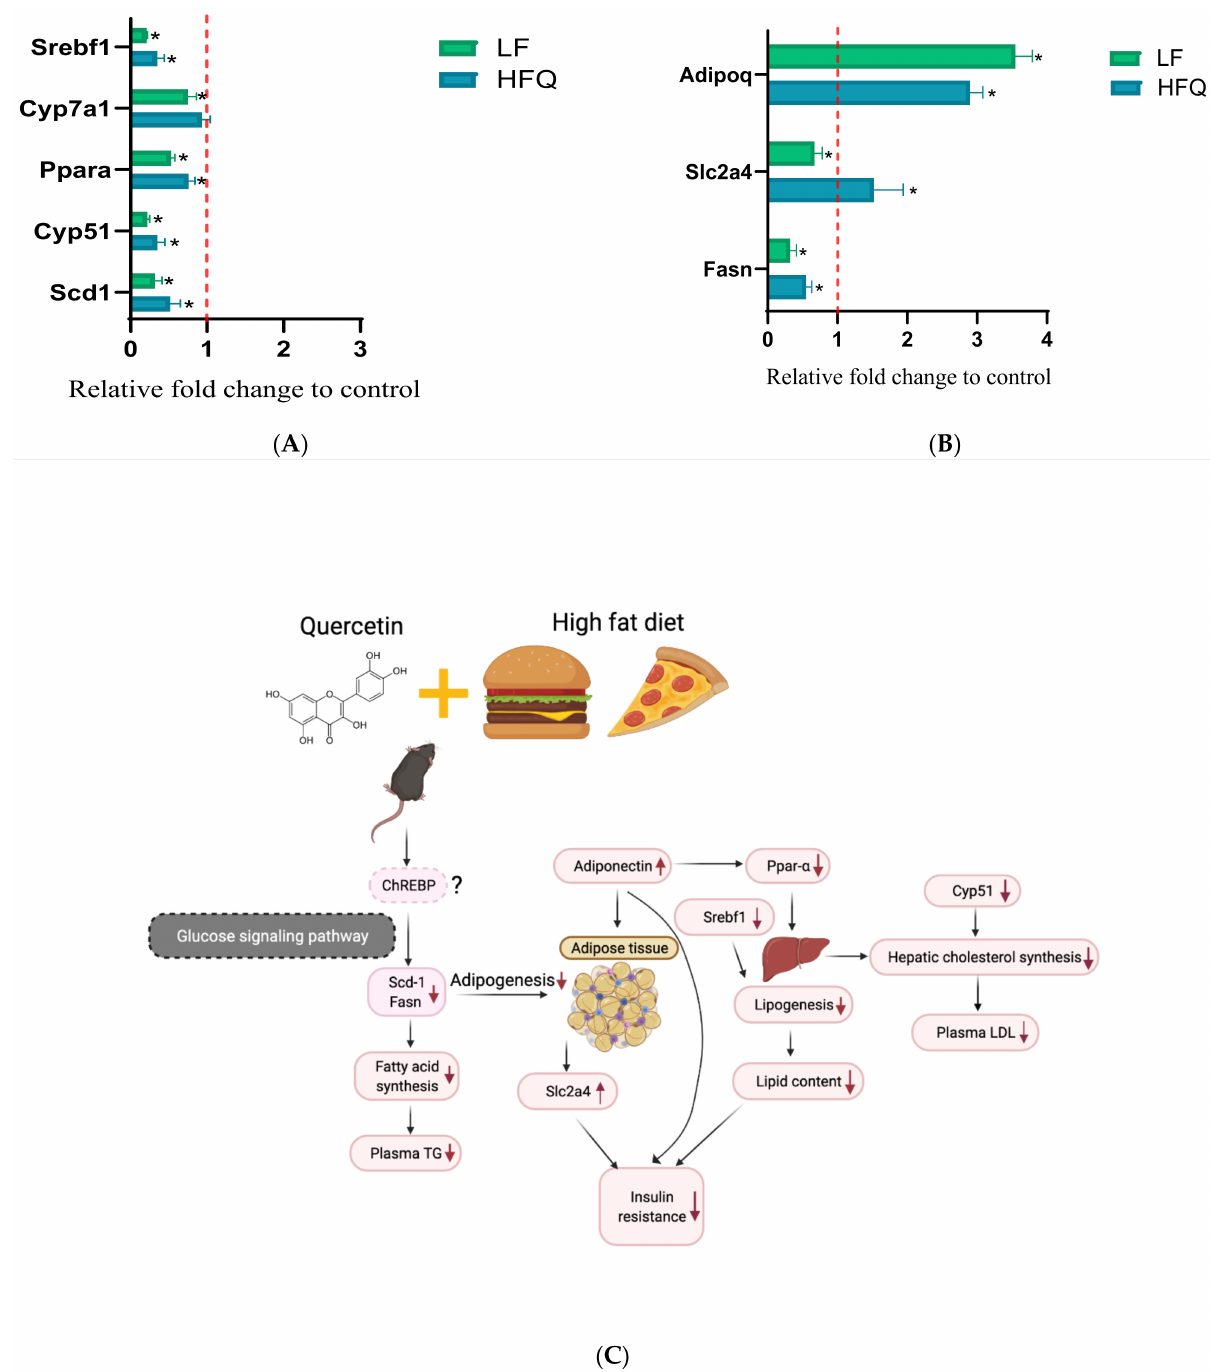
Figure 6. ( A ) Relative hepatic gene expression of Srebf1 , Cyp7a1 , Ppara , Cyp51 , and Scd1 in mice fed an HFQ diet compared to the HF diet (red dotted line), with the LF diet group shown as a reference. ( B ) Relative expression of Fasn , Slc2a4 , and Adipoq genes in epididymal adipose tissue of mice fed an HFQ diet compared to the HF diet, with the LF diet group shown as a reference. Data are expressed as the mean ± SE, n = 4/group. Differences in mRNA expression for livers and adipose tissue were calculated after normalizing to 35B4 mRNA expression. An asterisk (*) indicates a significant difference ( p < 0.05) compared to the HF diet. The dotted line (x = 1) represents the expression of control gene. ( C ) Proposed mechanism responsible for ameliorating insulin resistance in mice fed an HF diet supplemented with quercetin, involving the glucose signaling pathway, and ChREBP (dashes outline), as extrapolated from the literature